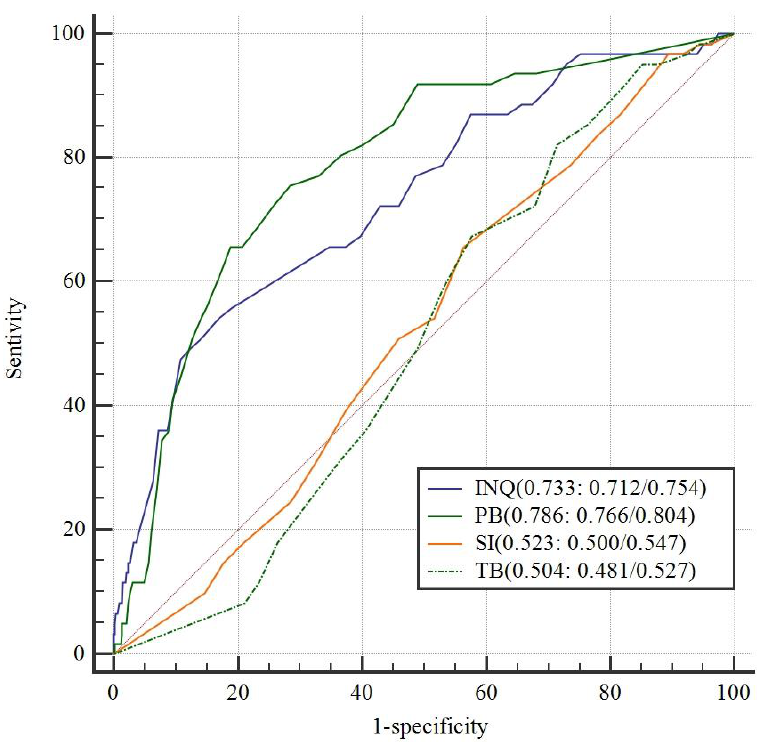
Figure 3. Receiver operator characteristic (ROC) curve for the Interpersonal Needs Questionnaire as a predictor of suicide ideation ( n = 1805).